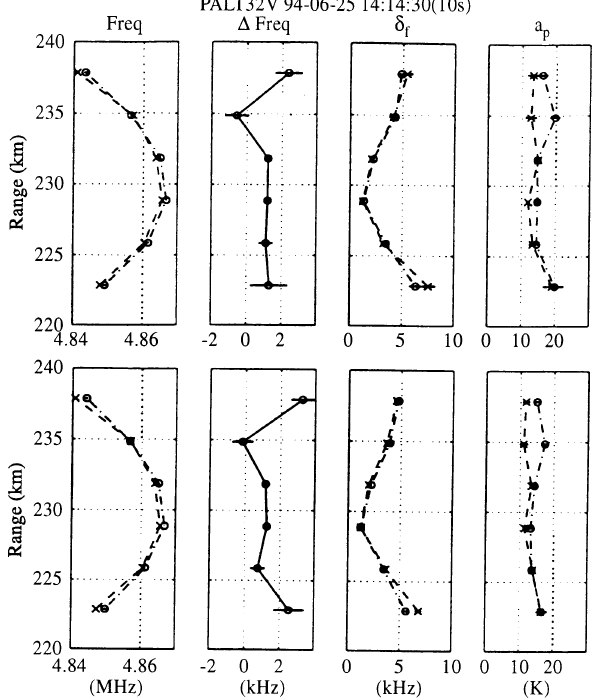
Fig. 5. The fitted parameters f (cid:114) , (cid:68) f (cid:114) , (cid:100) (cid:102) and a (cid:112) as well as the error bars from the data of Fig. 4 as a function of range. The dashdot line is for the parameters from the upshifted line, and the dashed one is for the downshifted lines. The four upper panels show the parameters for the squared-triangle model, the four lower panels for the Gaus- sian model